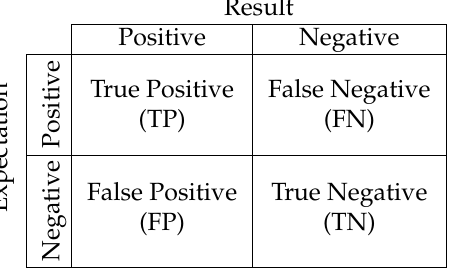
Figure 7. Possible results for binary